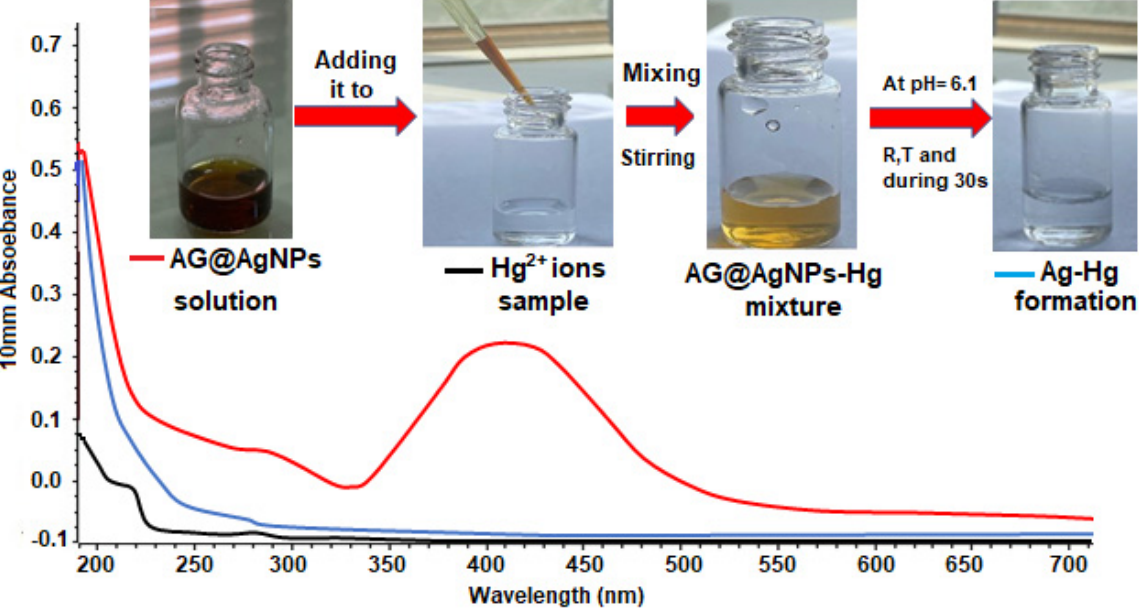
Figure-1. Measured UV − Vis spectra of Hg 2+ (black line), AgNPs@AG (red line), and Ag − Hg (blue line).